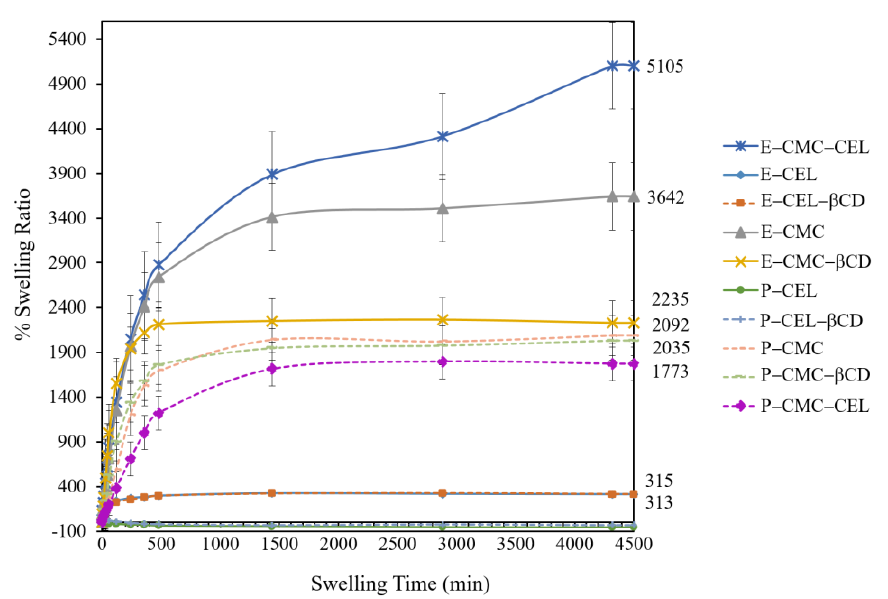
Figure 8. Swelling properties of CEL, CEL − β CD, CMC, CMC- β CD and CMC − CEL gels with ECH and PEGDE cross linkers in distilled water.